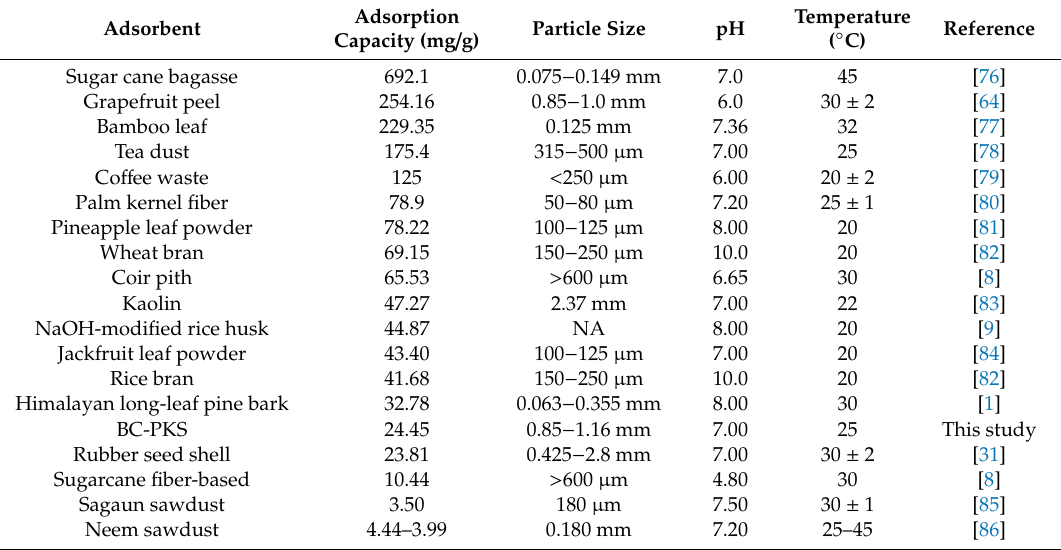
Table 3. Comparison of CV adsorption capacity to various adsorbents.